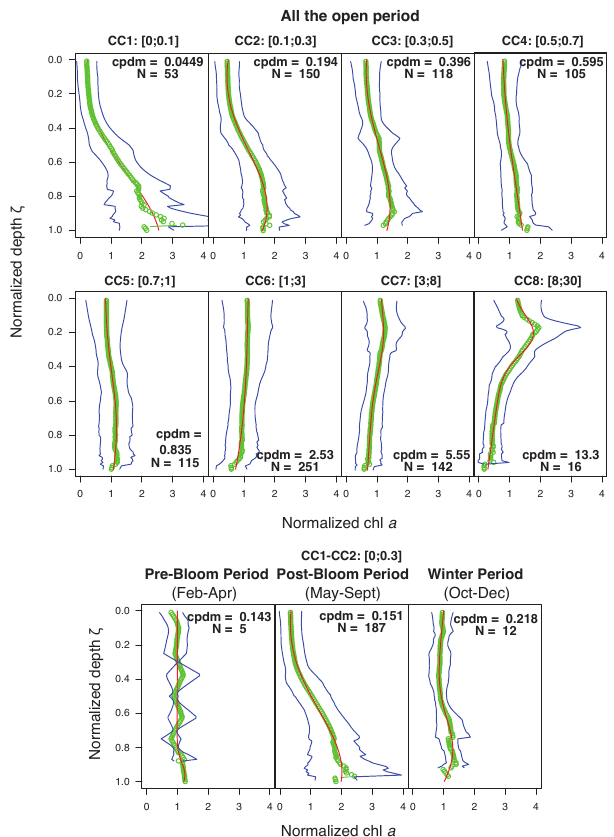
Fig. 8. Average dimensionless chlorophyll a (Chl a ) profiles (green lines) obtained for each category (CC1–CC8) during the open wa- ter period and for the combined category (CC1–CC2) of the dif- ferent periods (i.e., pre-bloom, post-bloom, winter period) at shal- low ( ≤ 50m) Arctic stations. Red and blue lines represent the pa- rameterized vertical Chl a profiles and standard deviation, respec- tively. N and cpdm represent the number of stations and the aver- aged Chl a surf value, respectively.